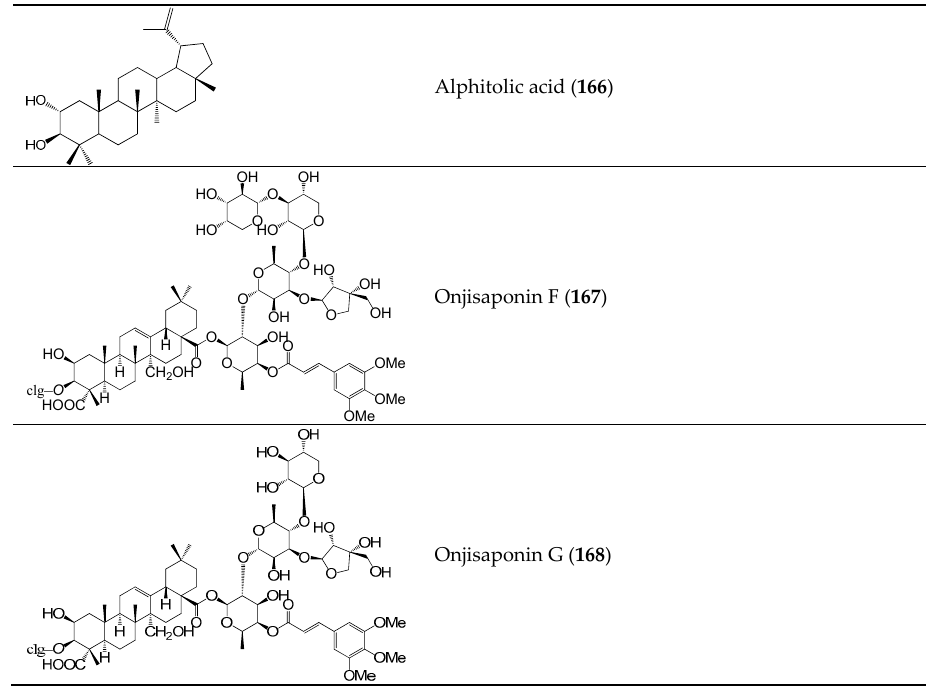
Figure 4. Chemical structures of iridoids, diterpenoids, terpenoids in Forsythiae Fructus.